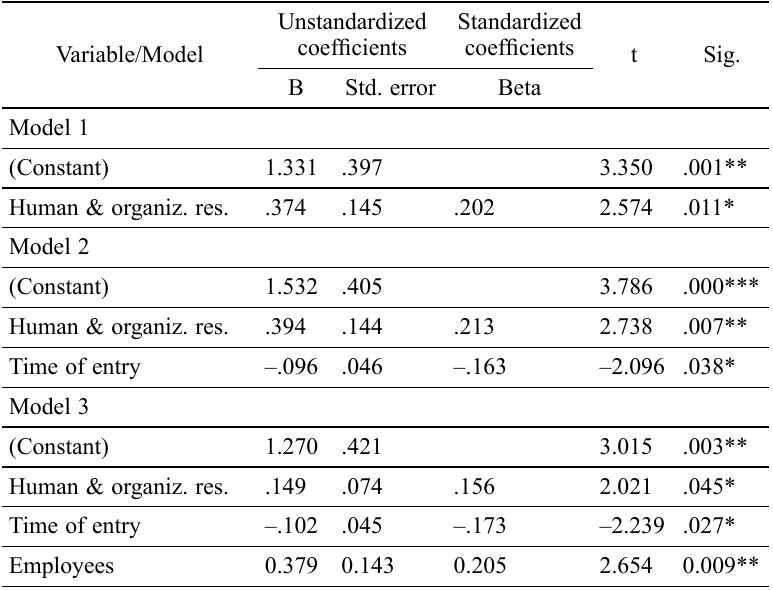
Table 3. Analyses of variance (ANOVA) for the regression analyses Sum of squares df Mean square F Sig. Regression 19.001 3 6.334 5.158 .002 ** Residual 189.120 154 1.228 Total 208.121 157 Note: **significant at p < 0.01. Table 4. Coefficients for the regression analyses Unstandardized Standardized coefficients Variable/Model